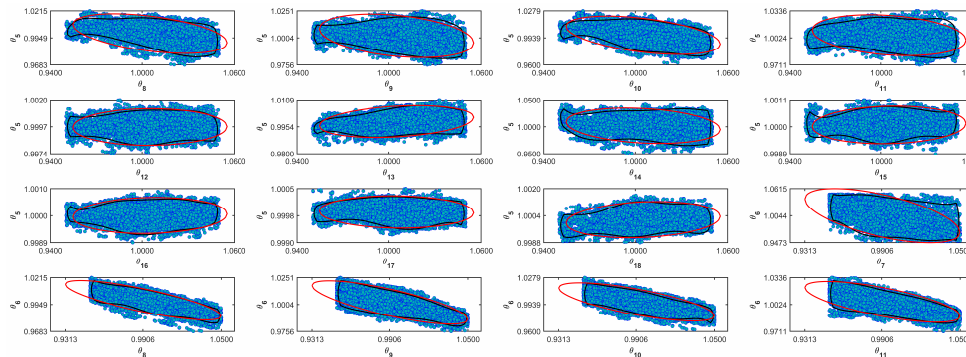
Figure A5. Coverage regions of parameters 05: (—) Gaussian region; (—) Possolo [33] region.